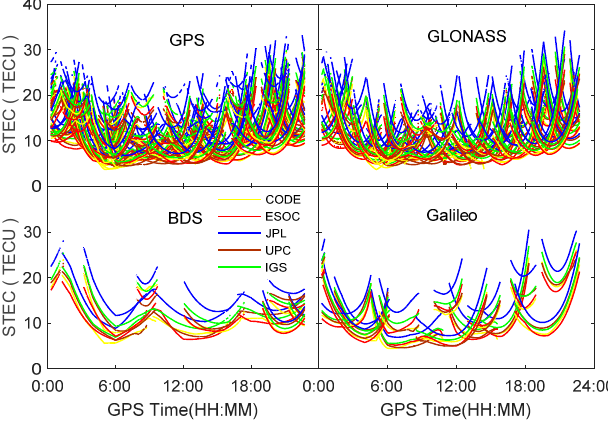
Figure 1. Slant TEC derived from different agencies at station PFRR on 4 September 2016.